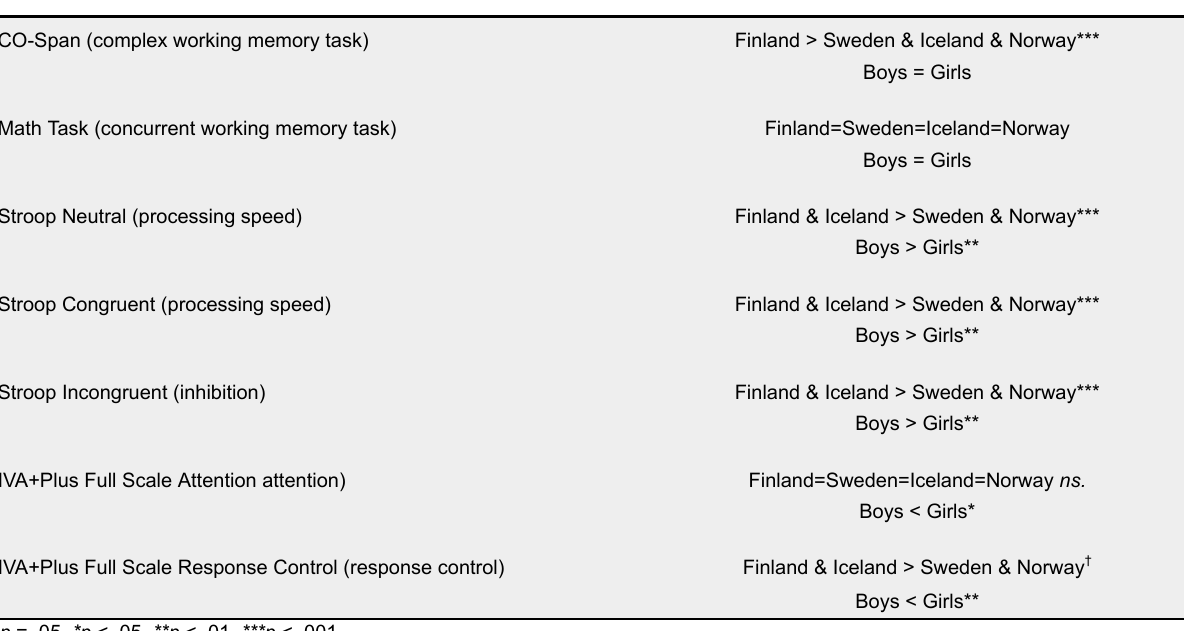
Comparing Countries and Gender CO-Span (complex working memory